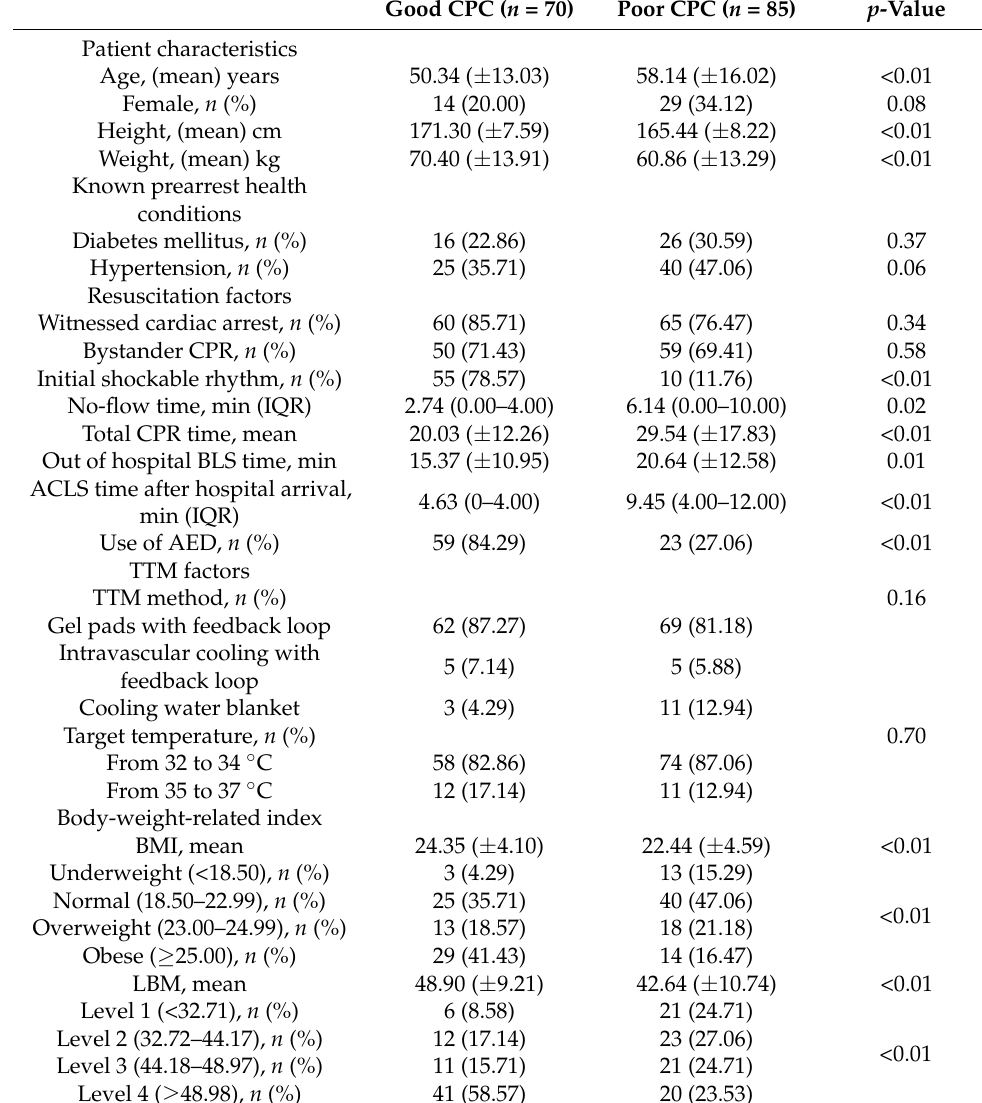
Table 1. Baseline characteristics of the study